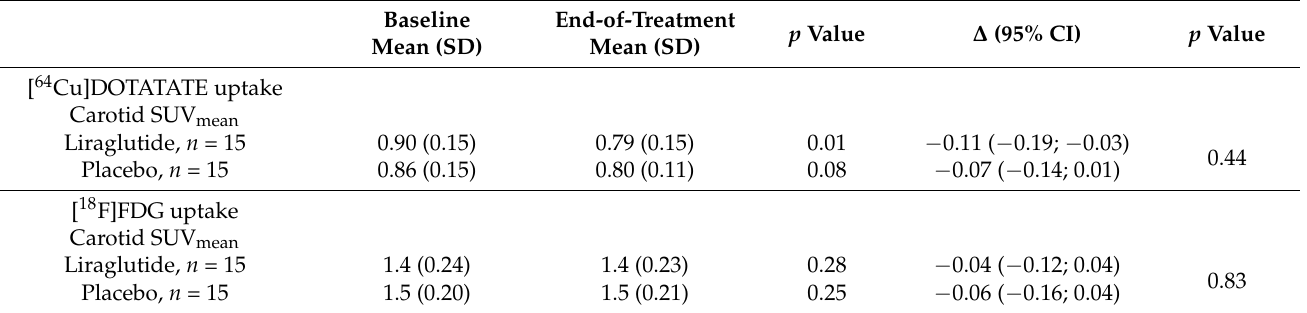
Figure 3. Effect of liraglutide and placebo on vascular inflammation evaluated with [ 64 Cu]DOTATATE PET in the carotid arteries. [ 64 Cu]DOTATATE uptake evaluated as mean standardized uptake values at baseline and end-of-treatment for the individual participants. Paired t -test was used to compare baseline and end-of-treatment values within groups. Table 3. Carotid inflammation evaluated with PET in 30 persons with type 2